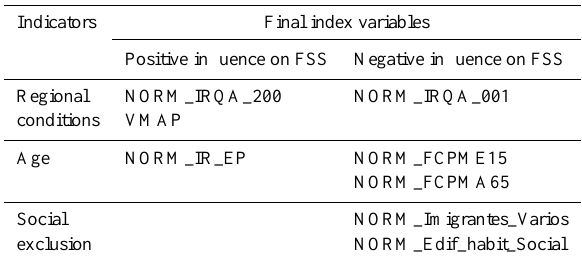
Table 6. Final set of variables included in each indicator that com- posed the final flood SSI.